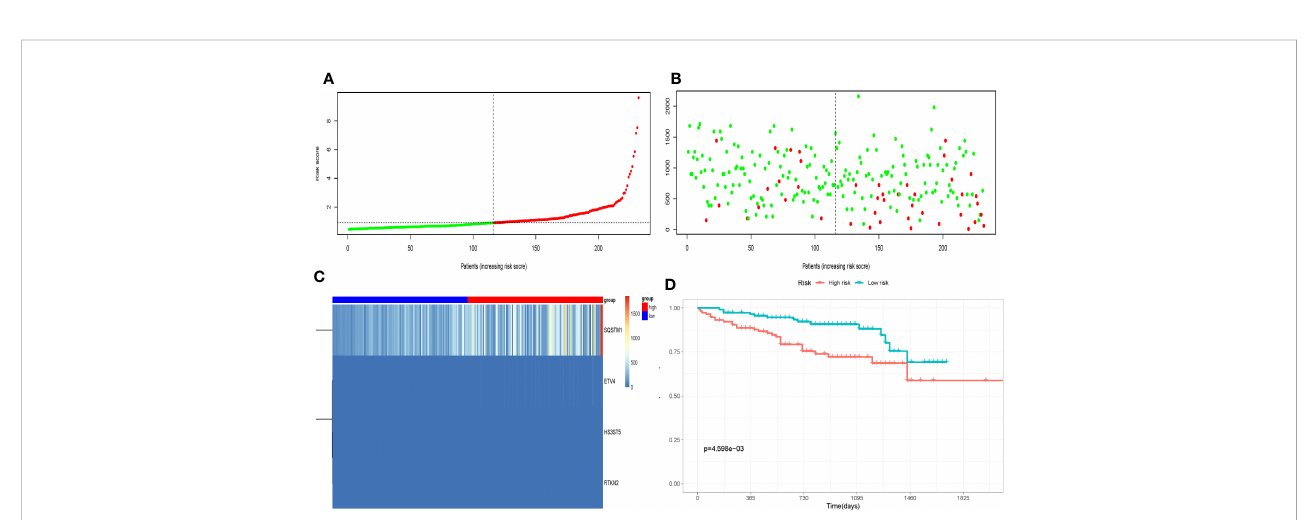
FIGURE 5 Validation of the super enhance based prognostic risk signature in the LIRI-JP cohort. (A) The risk score distribution of HCC patients; (B) Survival status and duration of patients; (C) Heatmap of the expression of the immune-related genes; (D) Survival curves for the low-risk and high-risk groups.